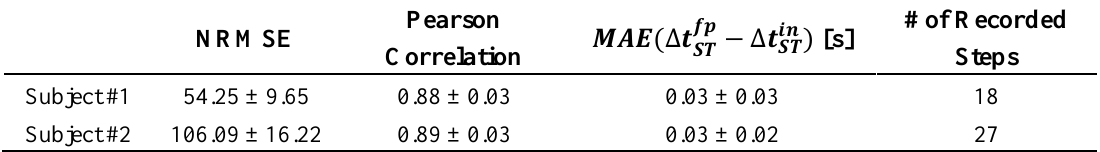
Table 2. Comparison between calculated from the insole and force-platform data: normalized root-mean square error (NRMSE), Pearson correlation coefficient, and standard error in the estimation of the stance phase duration (namely ). Data from slow- and normal-speed walking were grouped together. The last column reports the total number of steps that were both recorded by one of the insoles and the force